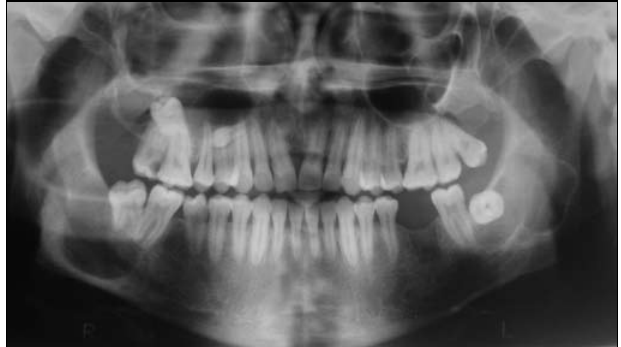
Fig. 3. Cropped section of chest radiograph showing forking of the 4th thoracic